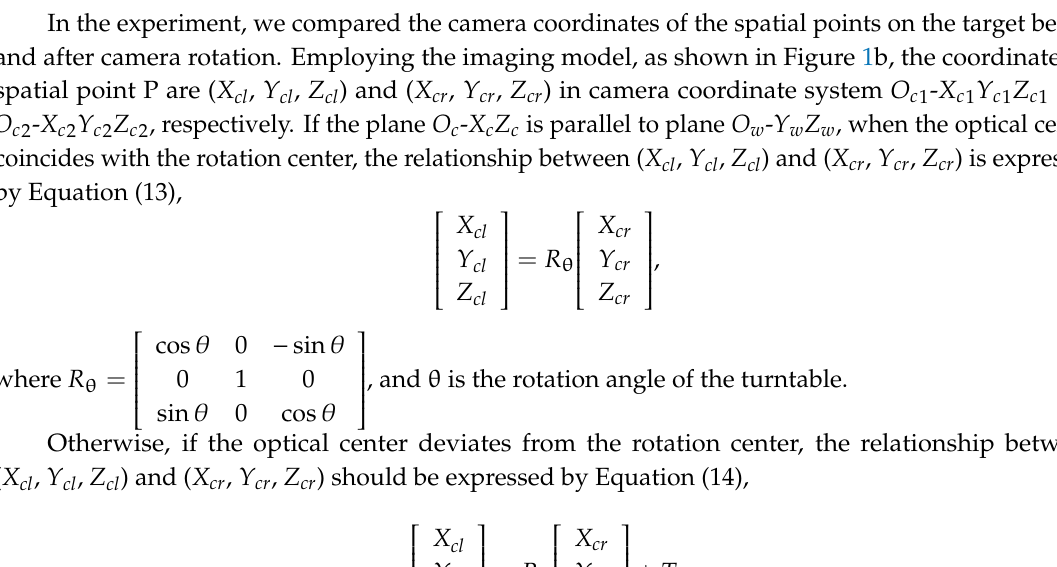
Table 5. The standard deviation of the angles of the four sets of marker points. Standard Deviation / Degree Red Circle Green Triangle Pink Diamond Blue Square Alignment 0.013 0.011 0.011 0.011 Misalignment 0.043 0.066 0.043